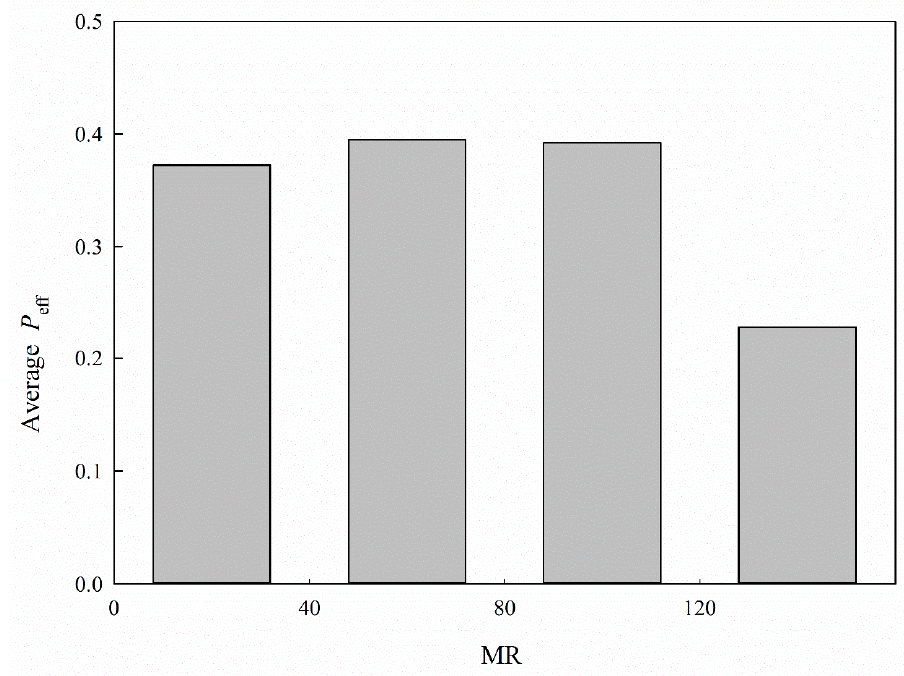
Figure 10. Average P e ff vs. the distribution of